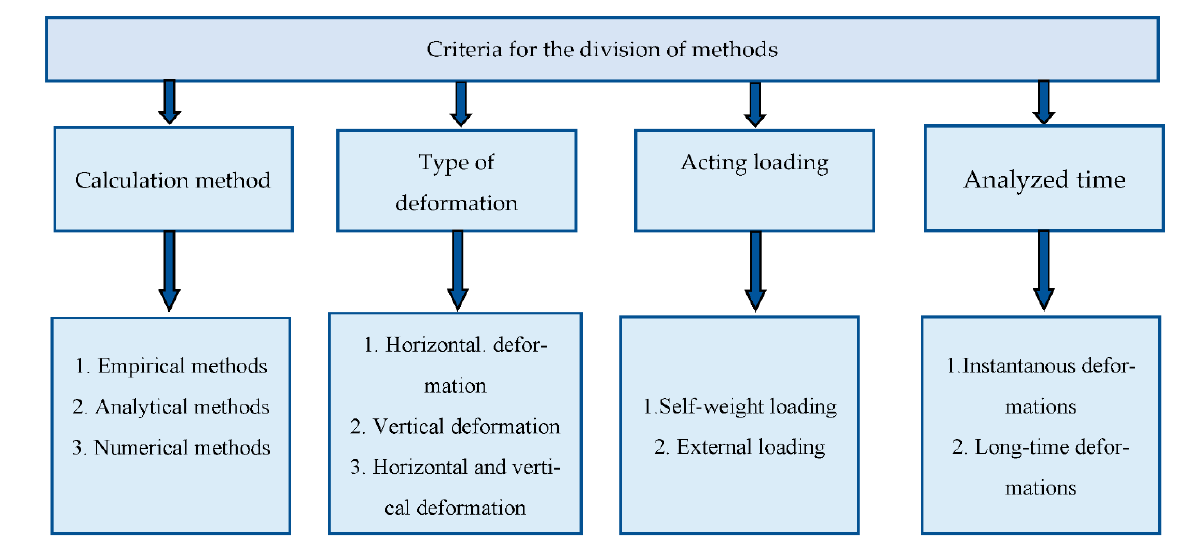
Figure 2. Methods used to investigate deformations in RS walls.